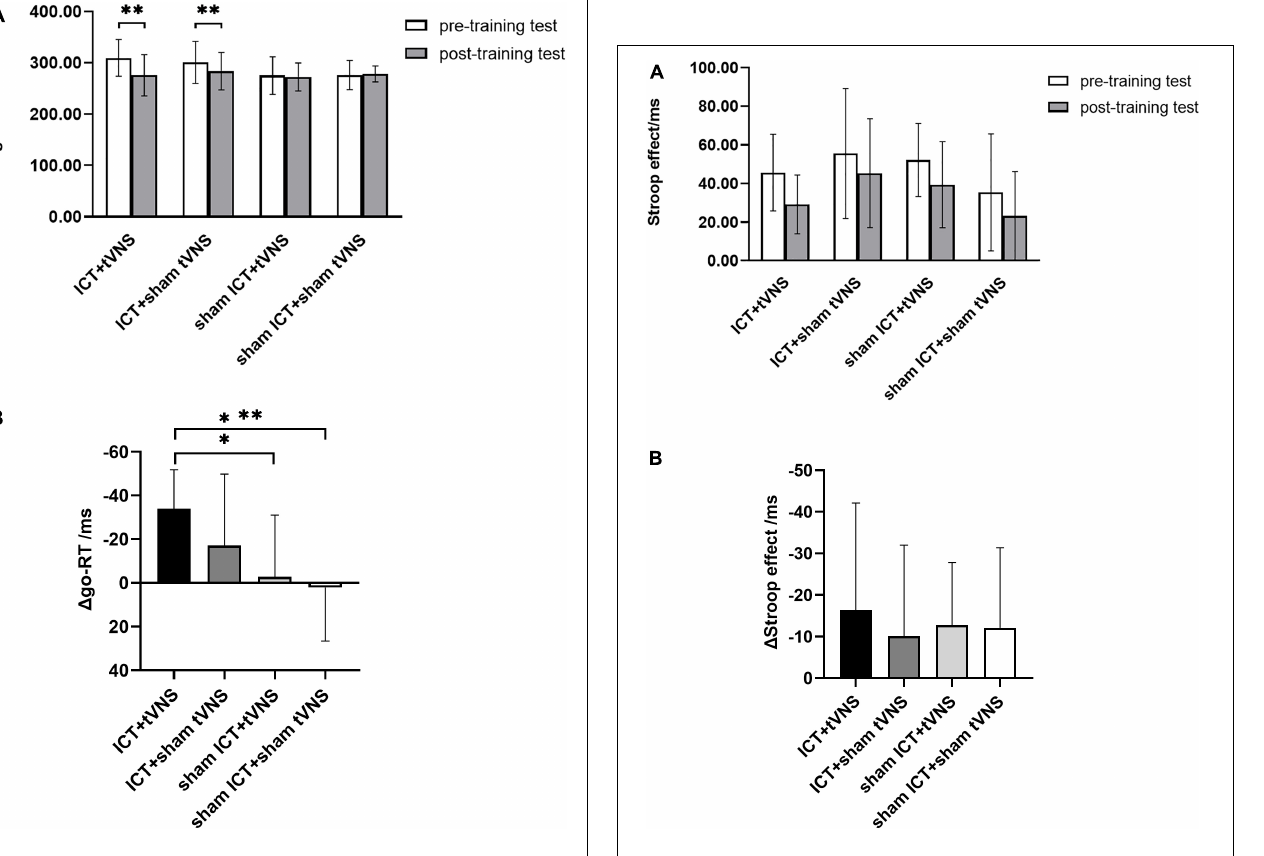
FIGURE 5 | (A) The performance of cwStroop tests: Stroop effect of the cwStroop between pre- and post-training tests. (B) The performance of cwStroop tests: The decrement of the Stroop effect for each group. Error bars represent the standard error of the